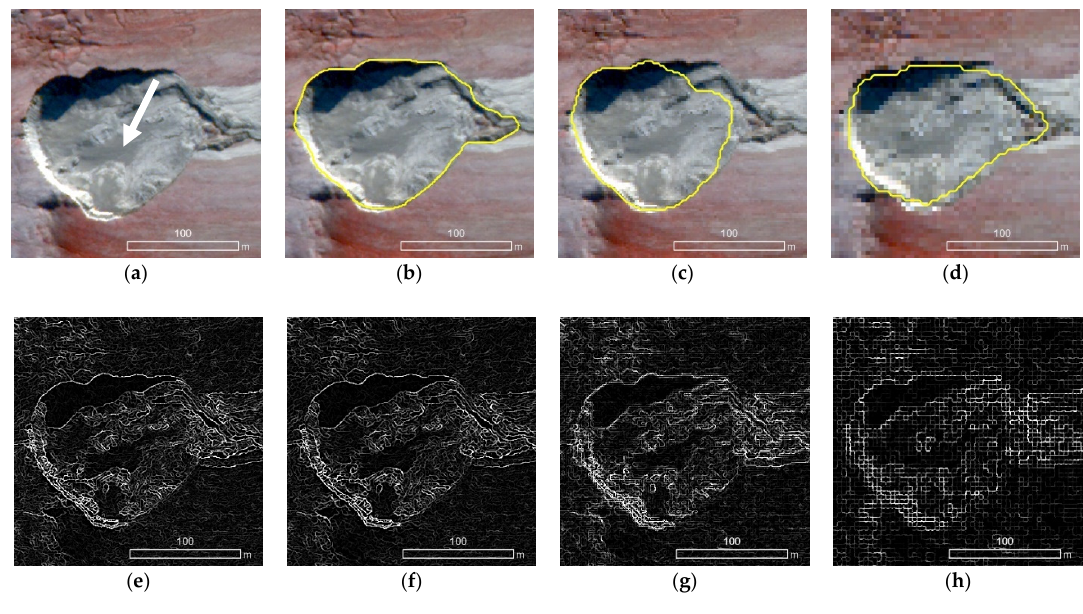
Figure 19. Exampled zoomed-in views ( a – d ) showing the effect of image resizing (spatial resolution degradation) on model predictions. Canny edge images of corresponding original and resized images are shown in ( e – h ). White arrows indicate the location of RTS. Underlying imagery is at 0.5 m resolution with false color composite. ( a ) Original image tile (2048 × 2048) at 0.5 m resolution. ( b ) Resized image at 1 m resolution (1024 × 1024). ( c ) Resized image at 2 m resolution (512 × 512). ( d ) Resized image at 4 m resolution (256 × 256). ( e ) Canny edge raster at 0.5 m resolution. ( f ) Canny edge raster at 1 m resolution. ( g ) Canny edge raster at 2 m resolution. ( h ) Canny edge raster at 4 m resolution.